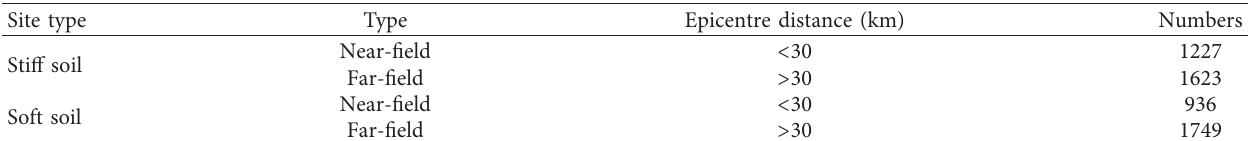
Table 4: Classification results of ground motion records based on epicentre distance.